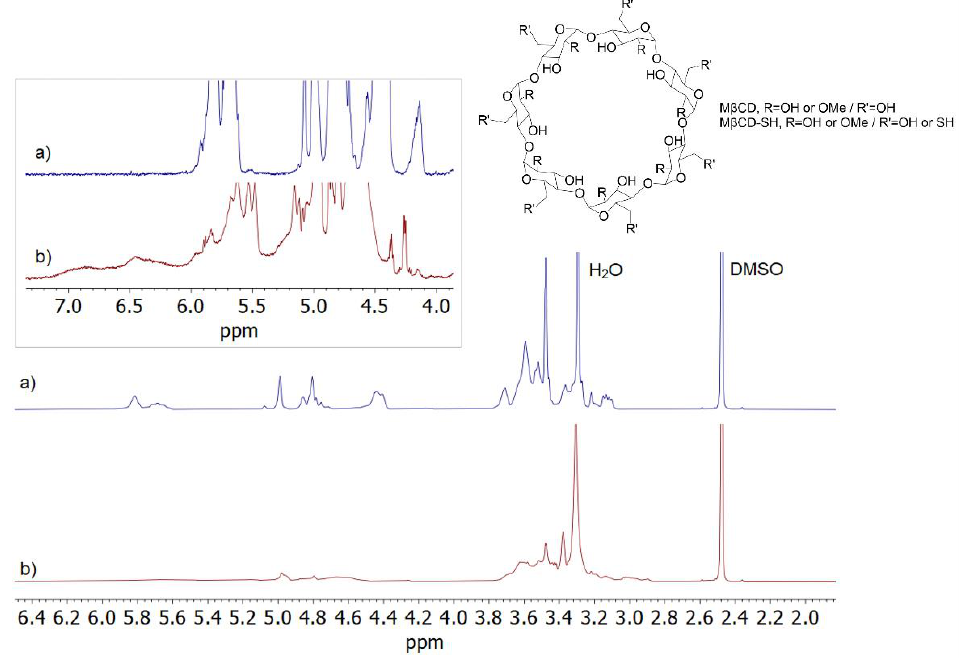
Figure 1. 1 H NMR (600 MHz, DMSO-d 6 , 25 °C, 5 mg/mL) spectra of: ( a ) MβCD, and ( b ) MβCD -SH.